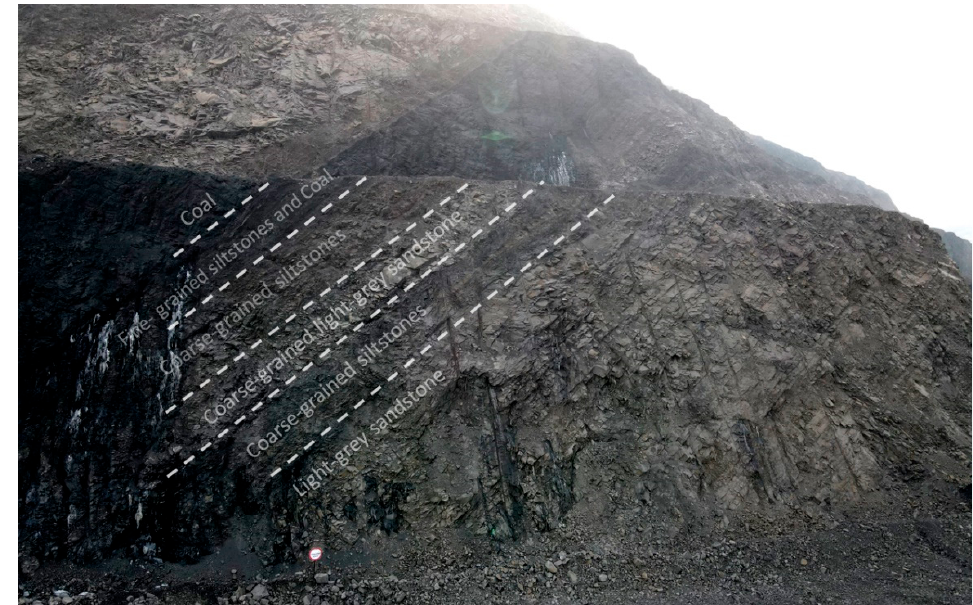
Figure 7. A comparison between scanned results and available geological data.